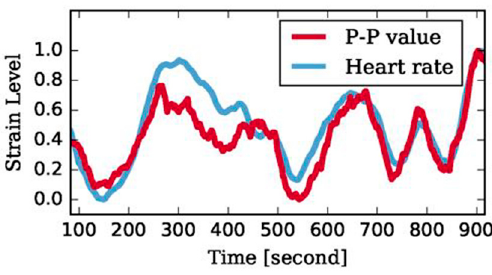
Figure 4. Comparison between normalized P-P values and heart rates at padding of the participant, having the highest correlation value of 0.92.